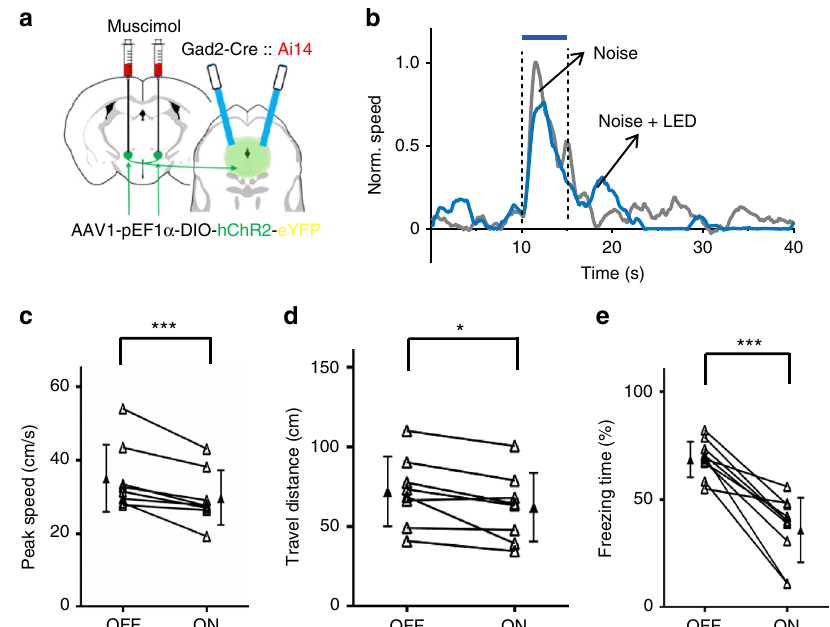
Fig. 8 The ZIr-PAG projection mediates the modulatory effects on defense behaviors. a Experimental paradigm. LED was applied to PAG, and muscimol was injected into ZIr as to prevent antidromic stimulation. b Normalized average speed responding to noise without (gray) and with (blue) LED stimulation plotted for an example animal. c Summary of noise-induced peak speed without and with activation of ZIr-PAG projections. *** p = 0.003, two-sided paired t- test, n = 8 animals. d Summary of noise-induced travel distance without and with activation of ZIr-PAG projections. * p = 0.021, two-sided paired t -test, n = 8 animals. e Percentage of time freezing during presentations of CS alone without and with activation of ZIr-PAG projections in conditioned mice. *** p < 0.001, two-sided paired t -test, n = 10 animals. Solid symbol represents mean ± s.d. for all